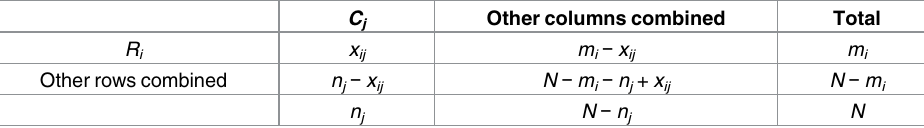
Table 2. Reorganized data for testing the independence from the ij -th cell. C j Other columns combined Total R i x ij m i − x ij m i Other rows combined n j − x ij N − m i − n j + x ij N − m i n j N − n j N